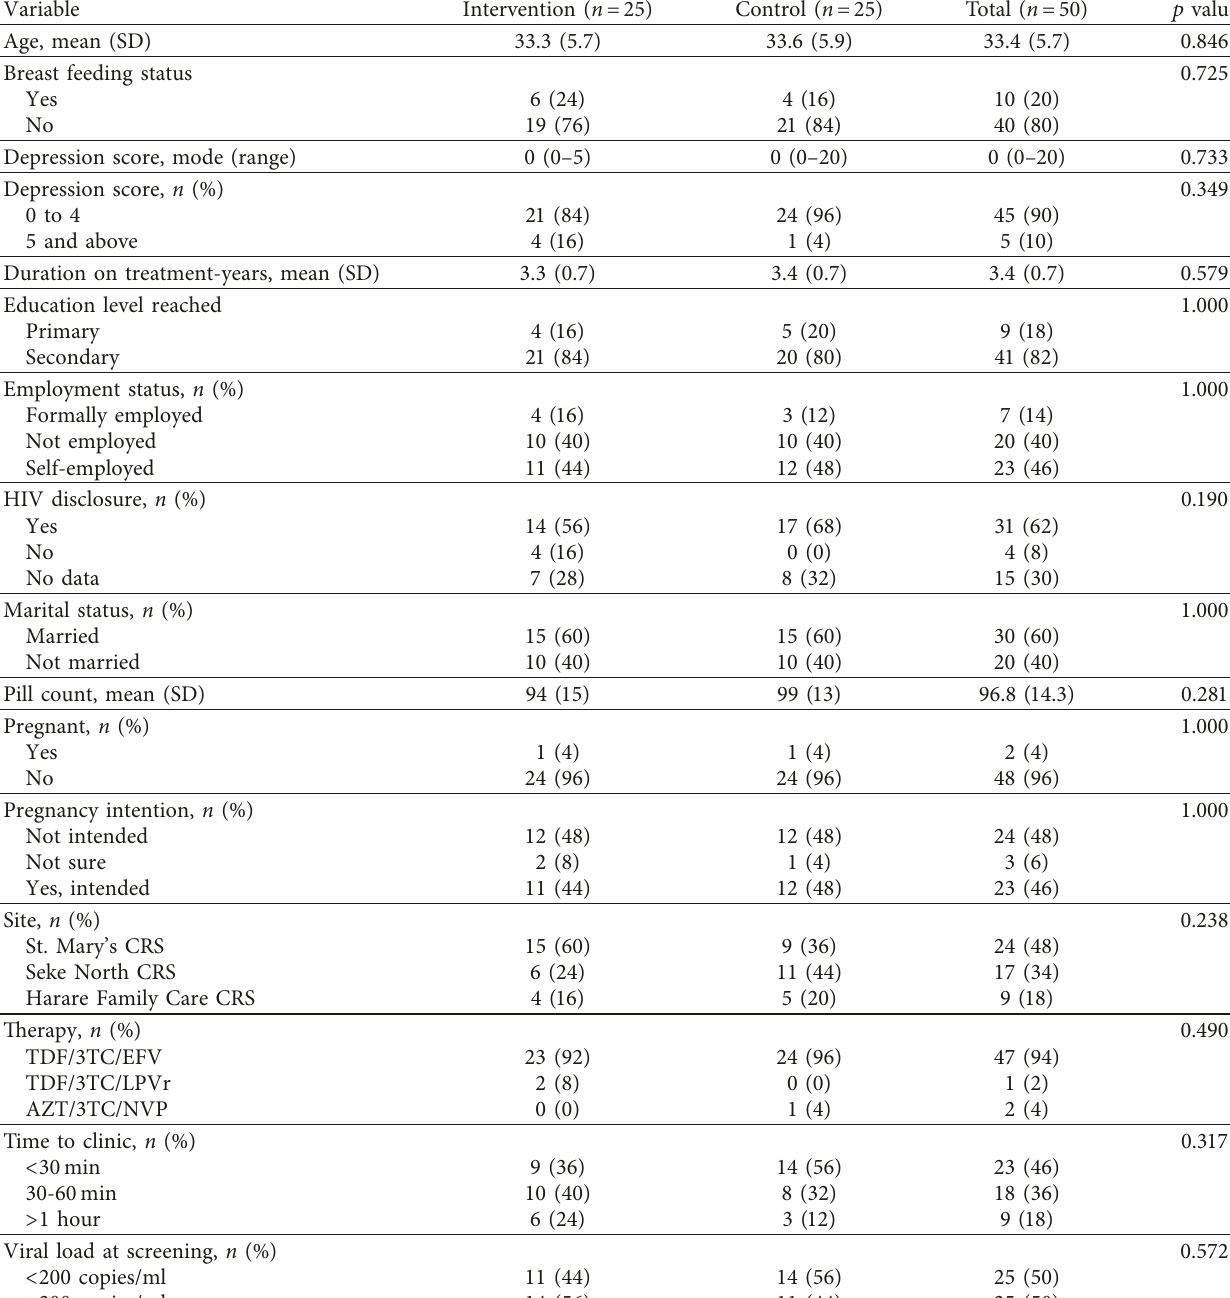
Table 1: Summary of baseline